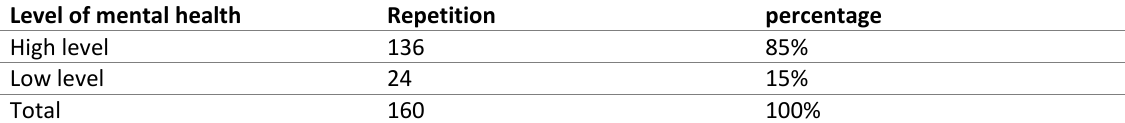
Table 1. Distribution percentages for members of sample on the mental health